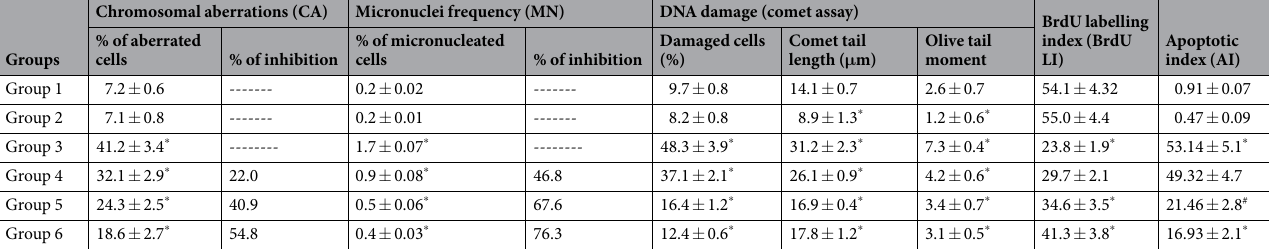
Table 1. Alteration of chromosomal aberration, micronuclei formation, DNA damage (comet assay), BrdU labelling index and apoptotic index (AI) in bone marrow cells by MUS in CBDCA-treated mice. Data are represented as mean ± SD, n = 6. * Denotes (P < 0.001), # denotes (P < 0.01) as compared to their respective control groups. Comparisons were made between Group 1 with Group 2 and 3; Group 3 with Group 4, 5 and 6.